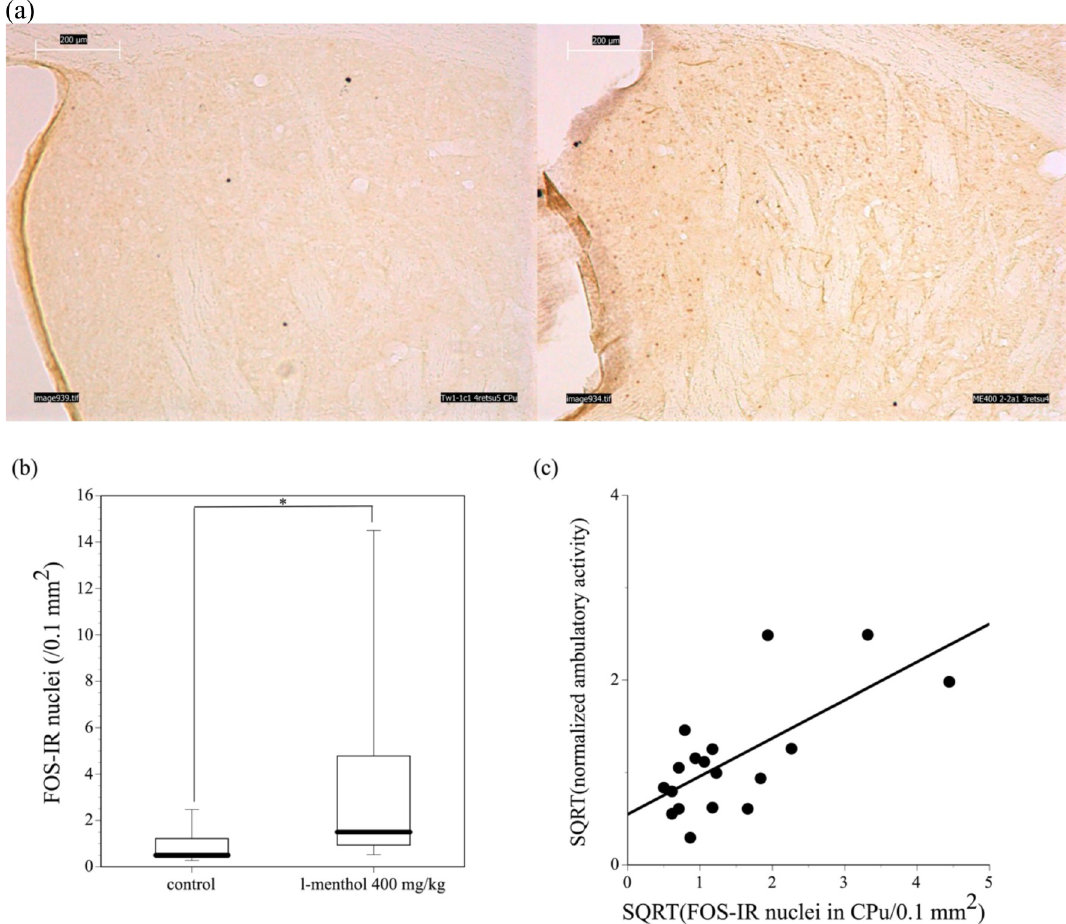
Fig 4. c-Fos-IR nuclei in the dorsal striatum (caudate putamen (CPu)) of mice administered saline or 400 mg/kg l -menthol. (a) Immunostaining for c-Fos in the dorsal striatum of a mouse administered saline (left panel) and a mouse administered 400 mg/kg l - menthol (right panel). Dark brown dots indicate c-Fos-IR-positive nuclei. Scale bars: 200 μ m. (b) Number of c-Fos-IR nuclei in the dorsal striatum of mice administered saline or l -menthol. Data presented in S2 Data are shown as box plots. � P < 0.05. N = 7 to 11. (c) Relationship between ambulatory activity and c-Fos-IR nuclei in the dorsal striatum. The best-fit regression lines were determined using the least-squares